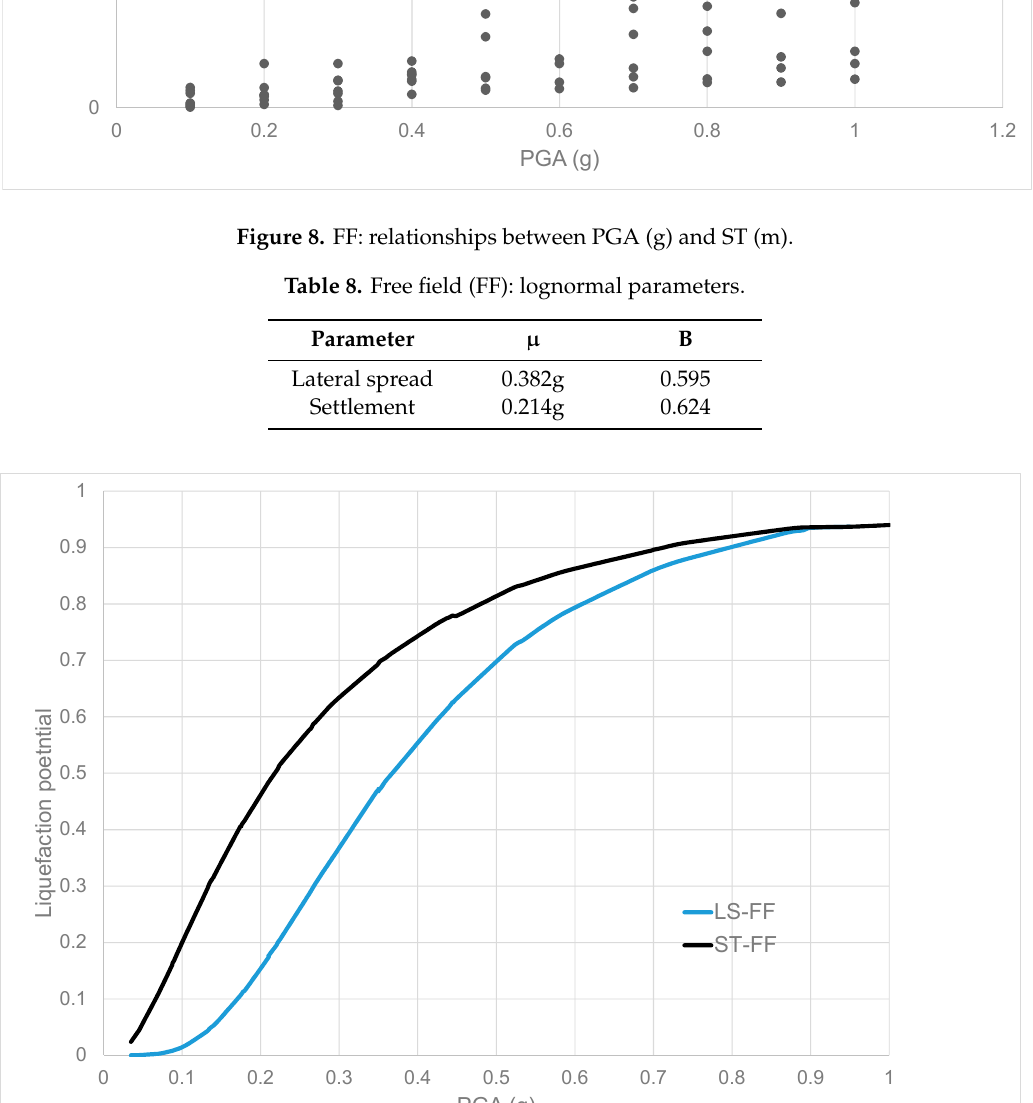
Figure 9. FF: liquefaction potential (LP): lateral spread (LS) and settlement (ST) comparison. Table 8. Free field (FF): lognormal parameters.